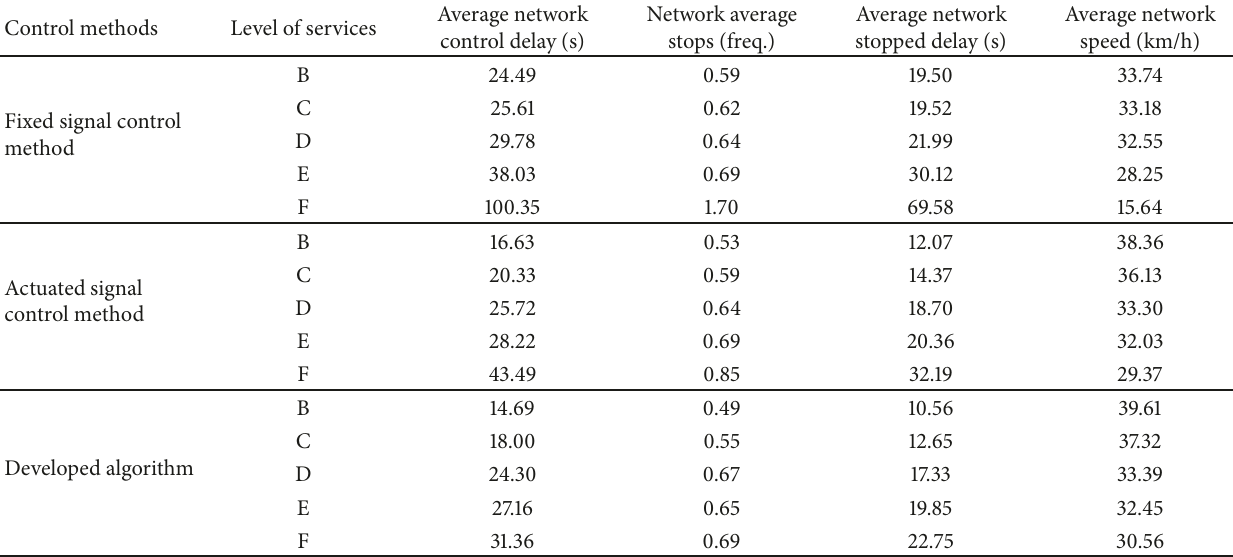
Table 2: Simulation result for each control method in an isolated intersection.